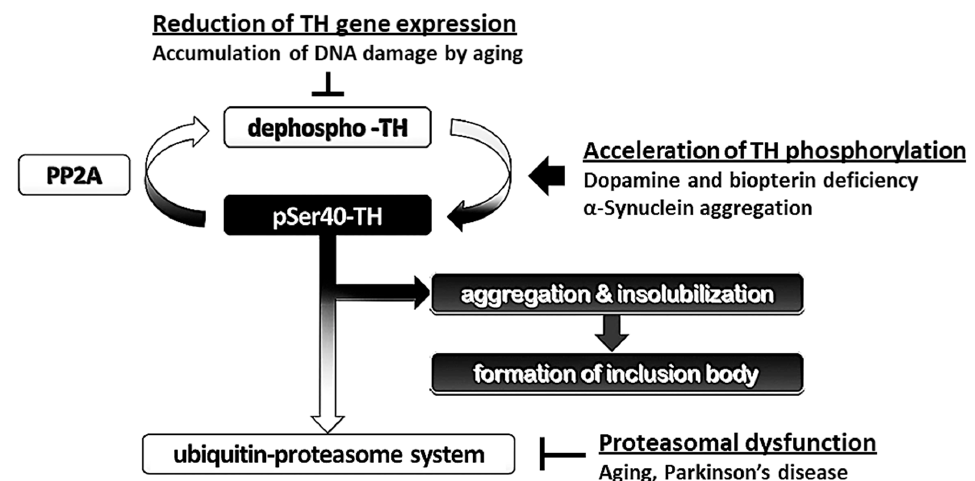
Figure 5. Schematic model for the pathways of degradation and accumulation of tyrosine hydroxylase (TH) protein. The ubiquitin-proteasome system degrades phosphorylated TH at serine 40 (pSer40-TH). Otherwise, pSer40-TH is accumulated in the proteasomal deficient state and forms insoluble aggregates.